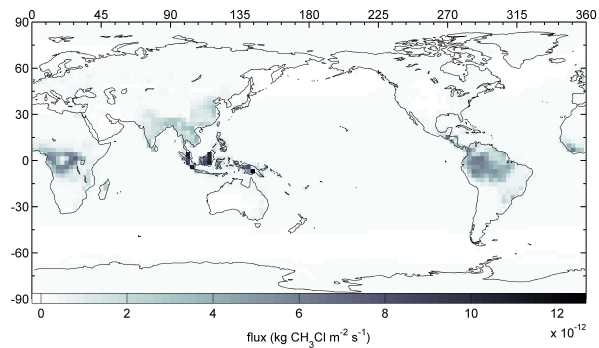
Fig. 13. A posteriori annual average distribution of combined CH 3 Cl surface fluxes from the estimated sources and sink, the con- stant industrial source, and the annual average wetland